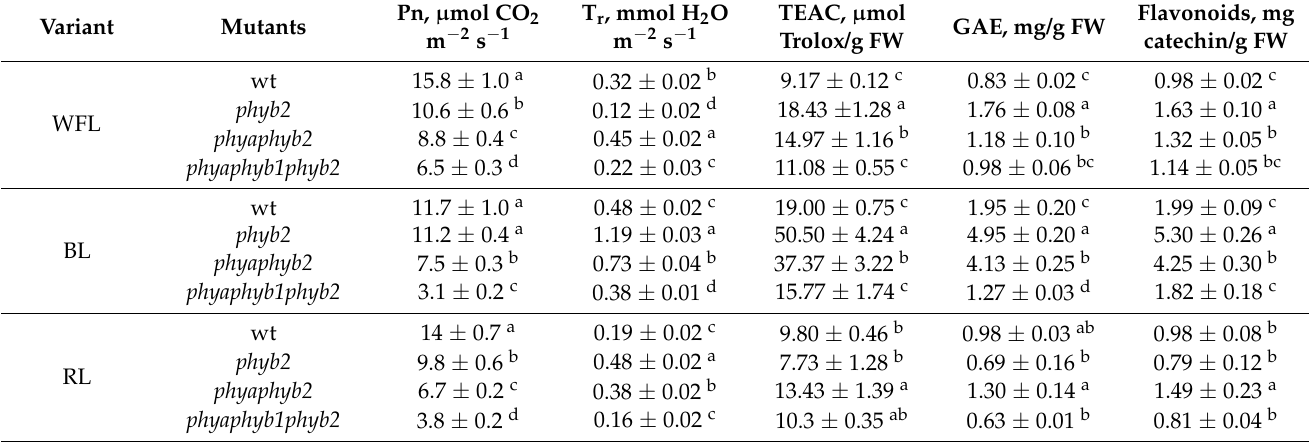
Table 1. Effect of WFL, BL and RL light on photosynthetic rate Pn ( µ mol CO 2 m − 2 s − 1 ),